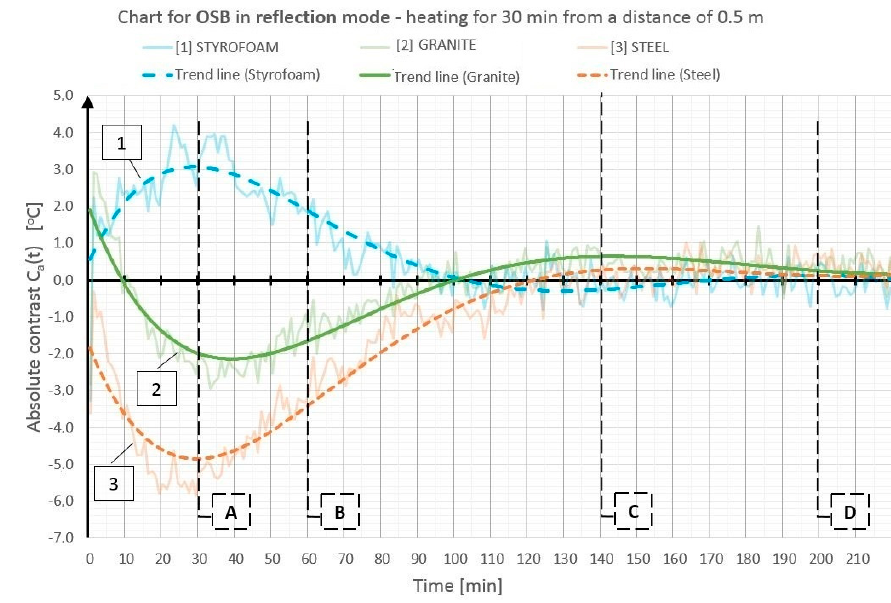
Figure 4. Diagram of the absolute contrast for measurement in a reflection mode for the OSB partition model with heating from a distance of 0.5 m (based on thermograms in Figure 3, row I).